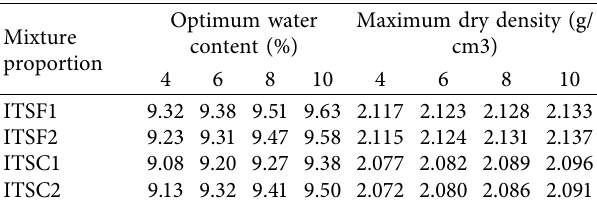
Figure 6: Pavement material strength tester. Table 5: Compaction test results.